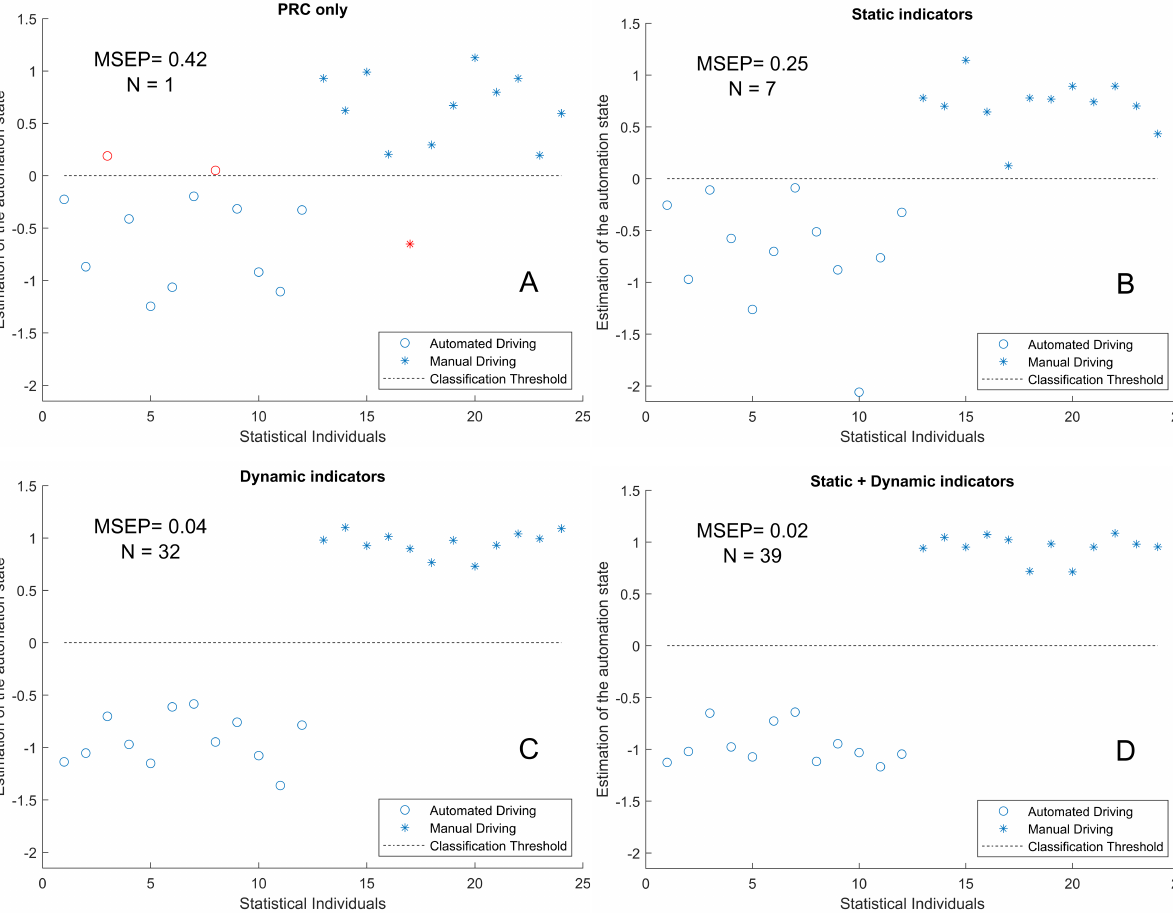
Figure 4: Estimations (markers) of the automation state from: A, PRC only; B, static indicators only; C, dynamic indicators only; D, static and dynamic indicators. The marker type indicates the real automation state: circle for automated driving, star for manual driv- ing. The MSEP and number of visual indicators retained during the PLS process (N) are annotated in text. Errors of classifications (relative to the classification threshold in black) are indicated in